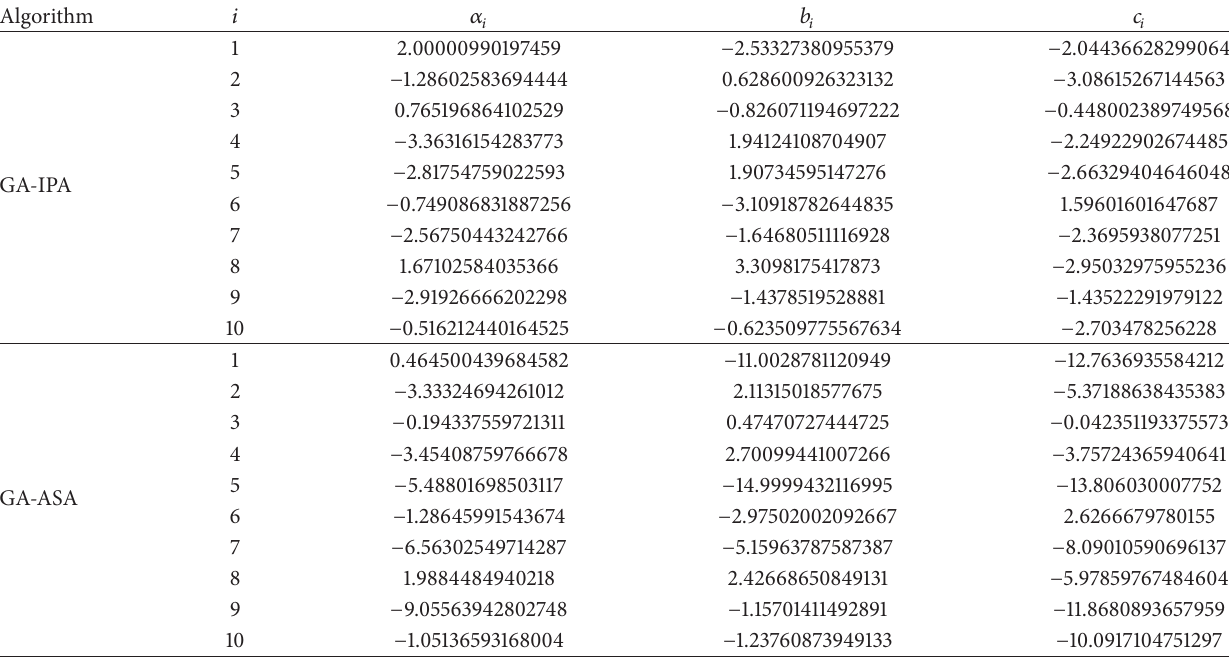
Table 6: Optimal values of adjustable parameters acquired by the hybrid schemes GA-IPA and GA-ASA (for 𝑚 = 0.25 ). Algorithm